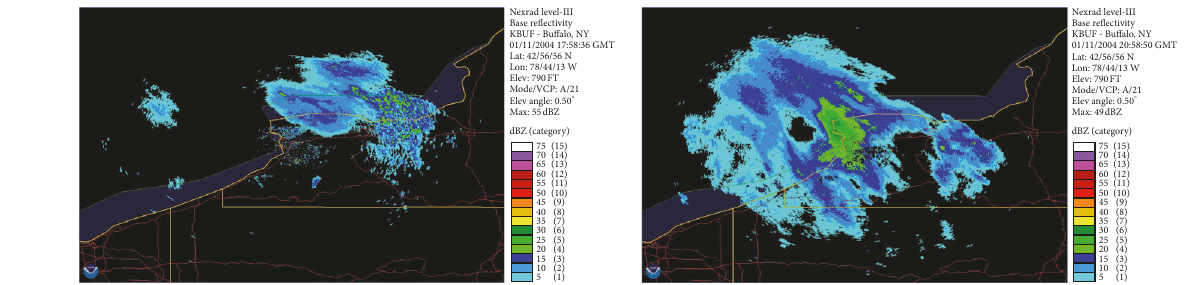
(a) National Weather Service Forecast Office Buffalo (KBUF) 0.5 ∘